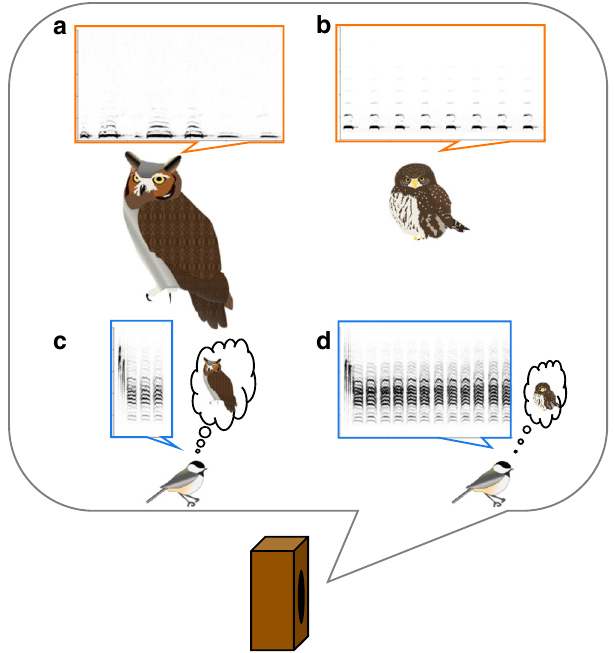
Fig. 1 Schematic of playback experiment. Nuthatches were exposed to playback of acoustic signals indicating a nearby predator of low or high threat. In the direct information treatment, we broadcast the vocalizations of a great-horned owls (low threat), and b northern pygmy-owls (high threat). In the indirect information treatment, we broadcast black-capped chickadee mobbing calls produced in response to c great horned owls, and d northern